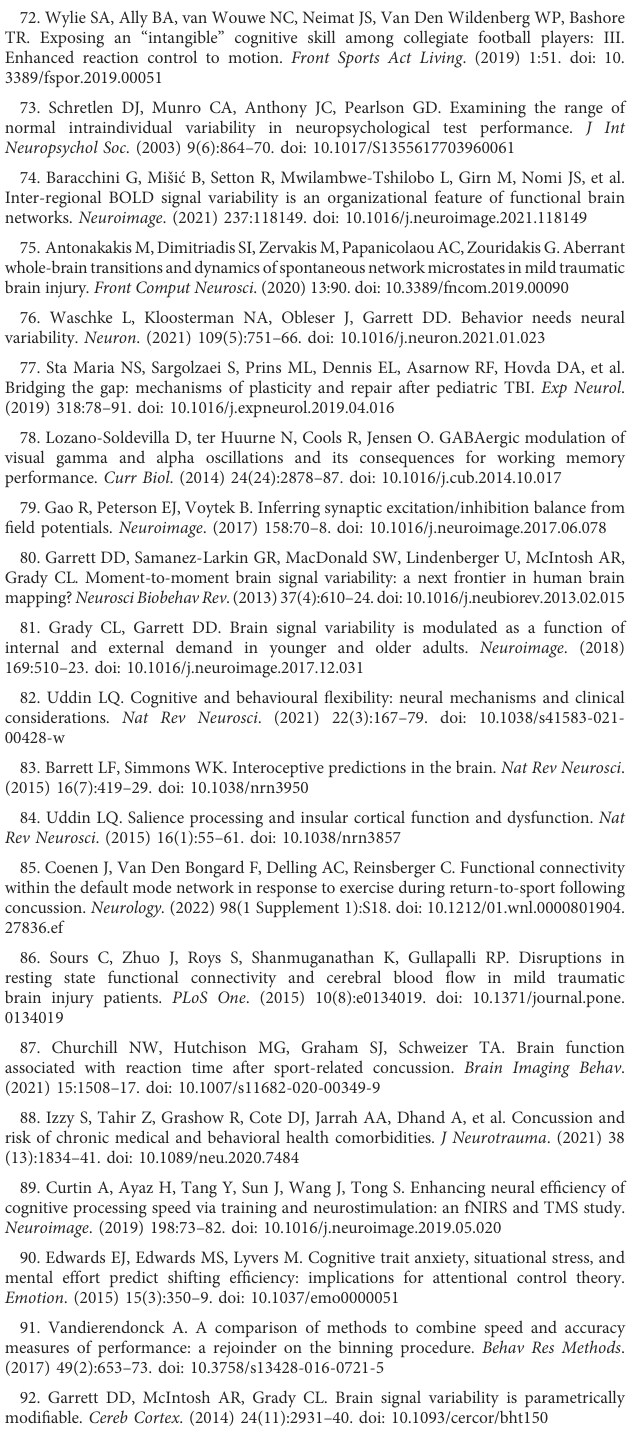
table tennis athletes. Front Behav Neurosci . (2019) 13:165. doi: 10.3389/fnbeh.2019.00165 70. Marzetti L, Basti A, Chella F, D ’ Andrea A, Syrjala J, Pizzella V. Brain functional connectivity through phase coupling of neuronal oscillations: a perspective from magnetoencephalography. Front Neurosci . (2019) 13:964. doi: 10.3389/fnins.2019.00964 71. Strong SL, Silson EH, Gouws AD, Morland AB, McKeefry DJ. An enhanced role for right hV5/MT+ in the analysis of motion in the contra- and ipsi-lateral visual hemi- fi elds. Behav Brain Res . (2019) 372:112060. doi: